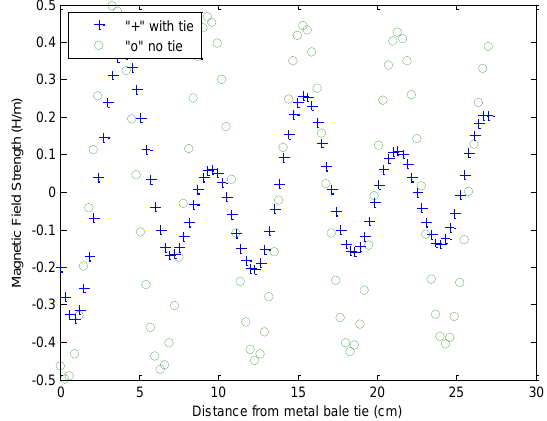
Figure 11. Another comparison of the two test cases, with versus without wire-ties from the final steady-state FDTD simulation, illustrates both the magnitude and phase shift that occurs due to the